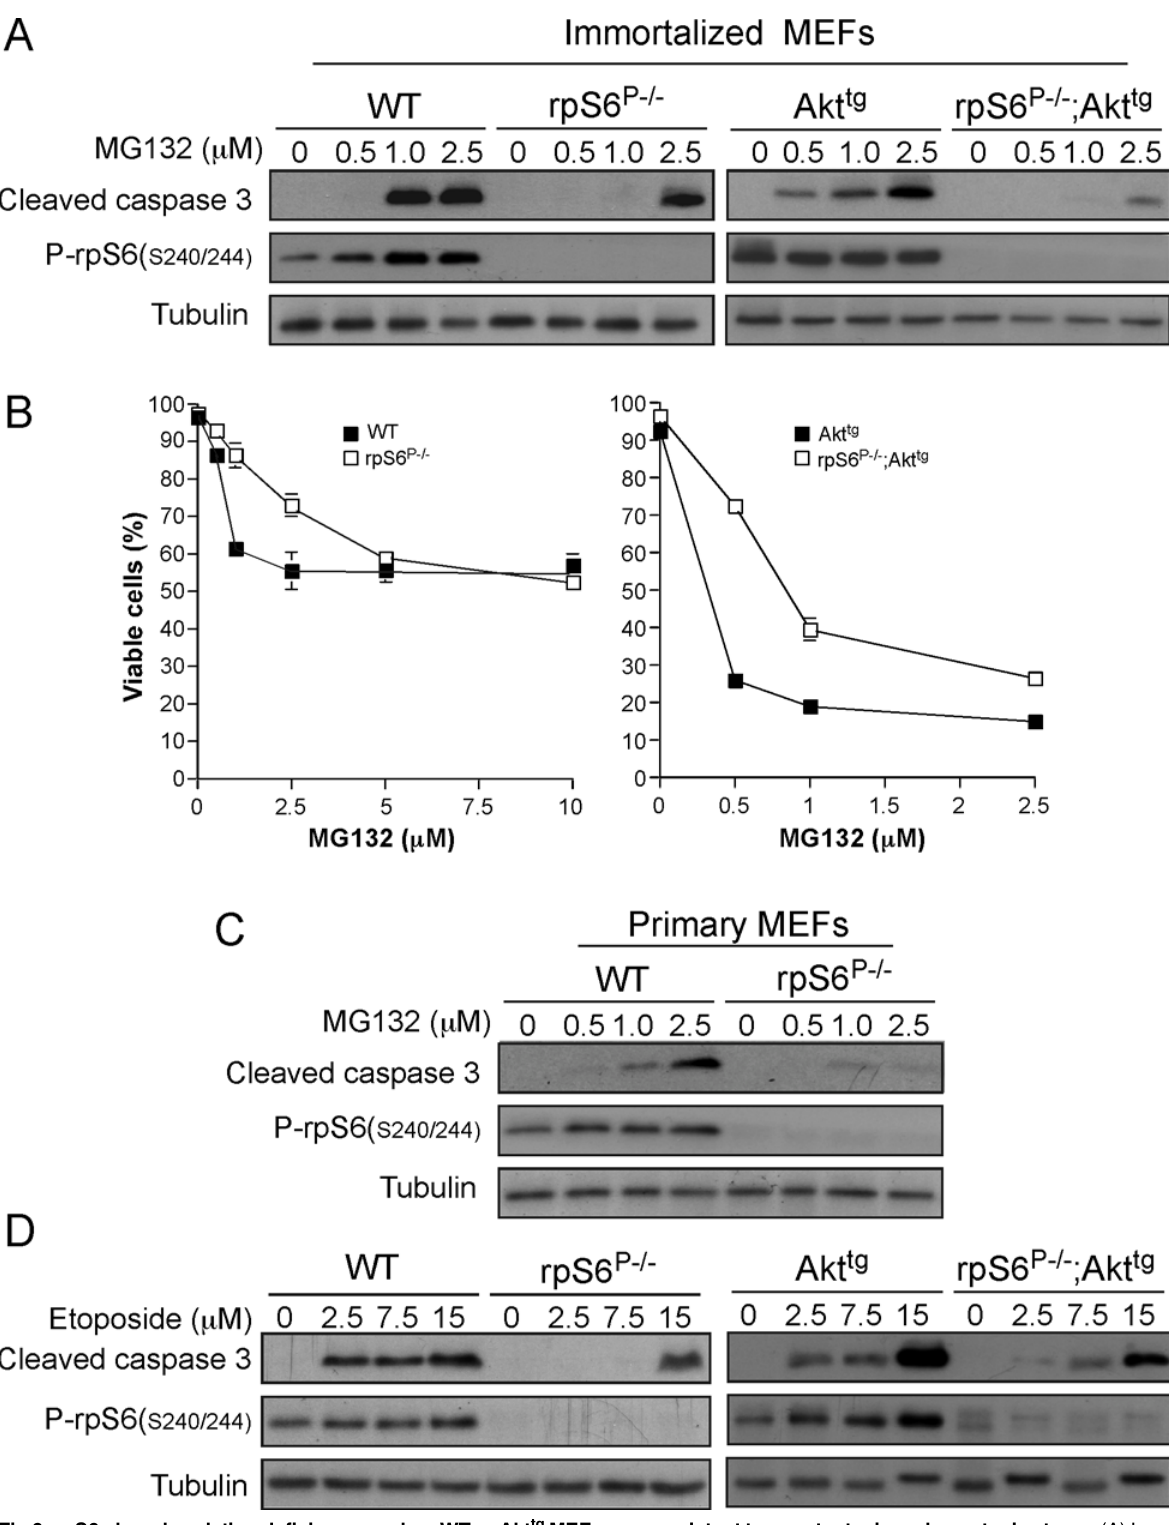
Fig 6. rpS6 phosphorylation deficiency renders WT or Akt tg MEFs more resistant to a proteotoxic and genotoxic stress. (A) Immortalized WT, rpS6 P-/- , Akt tg , and rpS6 P-/- ;Akt tg MEFs were incubated with the indicated concentrations of MG132 for 16 h, harvested and their cytoplasmic proteins were subjected to Western blot analysis with the indicated antibodies. (B) Viability of cells described in (A) was assessed by the Trypan blue exclusion assay,